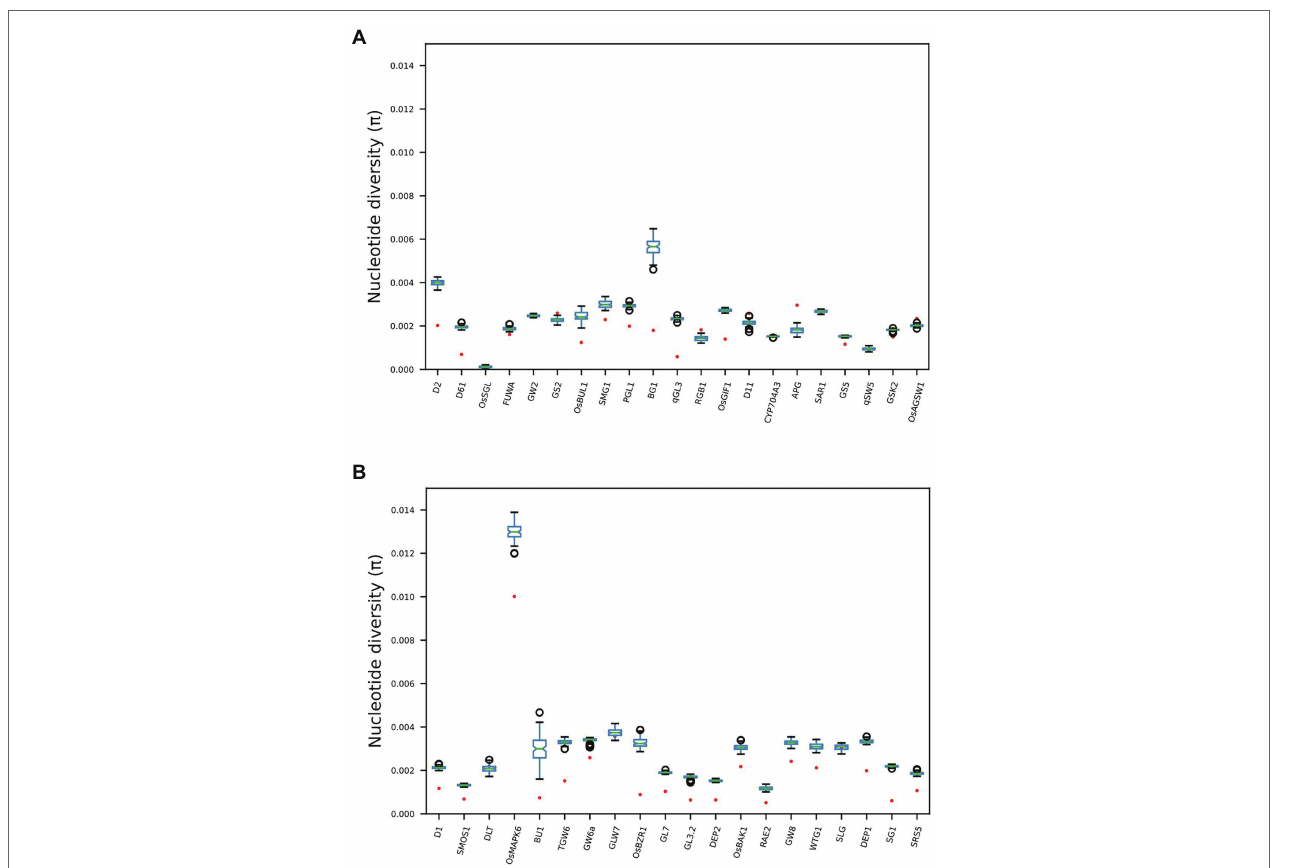
FIGURE 2 | Boxplots comparing nucleotide diversity ( π ) at 41 genes across the rice genome known to exert functional influence on rice grain size. Red dots indicate π across 279 Thai accessions, while boxplots indicate distributions of 100 subsampled (n = 279) estimates of π across 3KRG samples. Thai accessions have significantly reduced π at 28 gene regions compared with global diversity at these loci, while four genes show significantly elevated π among Thai accessions compared with the global database. See Supplementary Table S1 for full information regarding GL